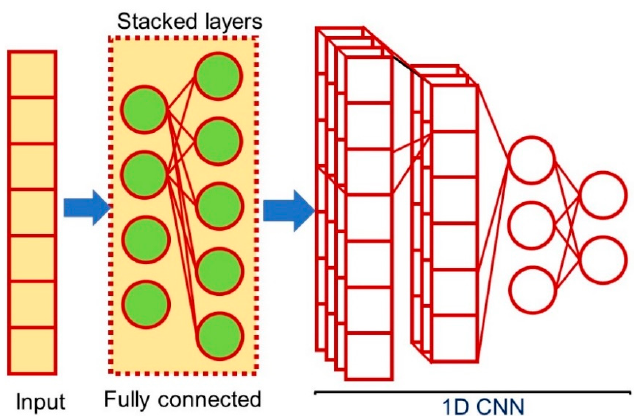
Figure 4. Schematic overview of the one-dimensional fully-connected layer first convolutional neural network (1D FCLF-CNN).